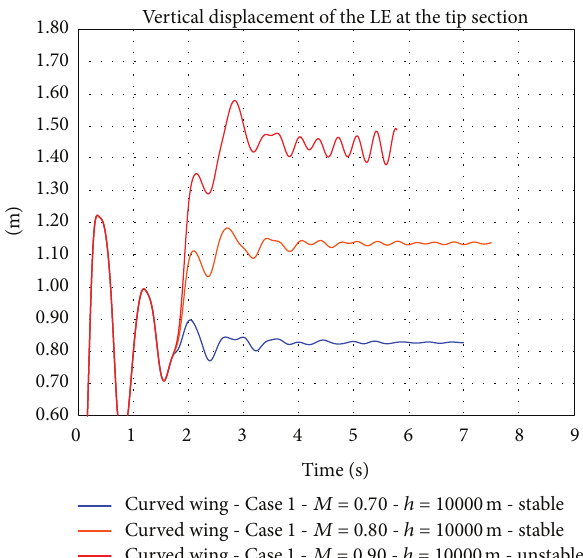
Figure 10: Results of the FSI analyses of the curved wing (Case 1 , cruise altitude).